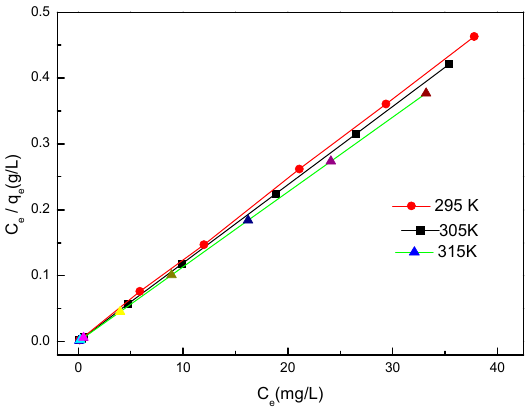
Figure 9. The Langmuir isotherms at different temperatures.